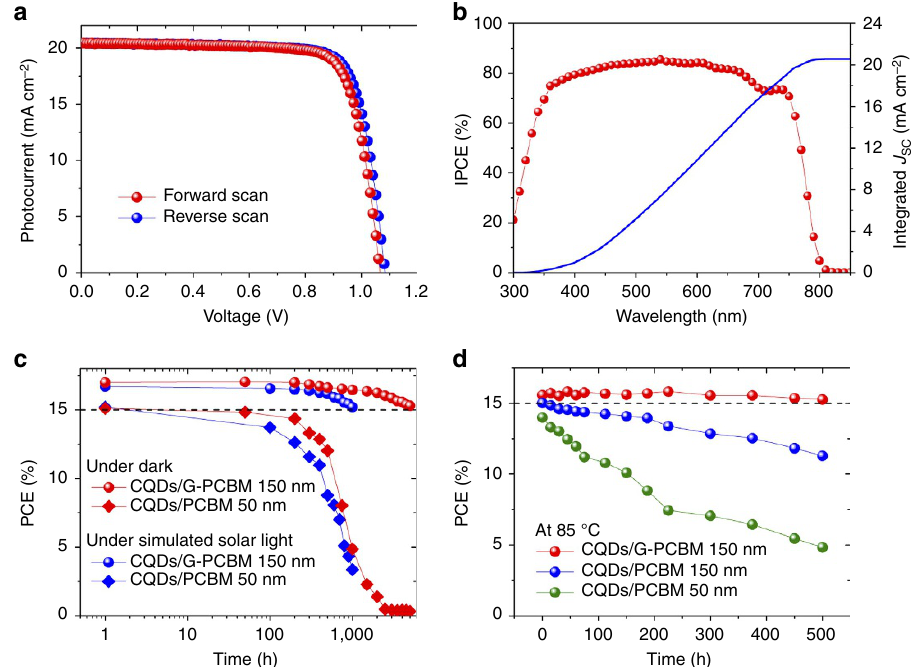
Figure 3 | Performance of PSCs. ( a ) The photocurrent current–voltage characteristics of one device with the structure of NiMgLiO/Perovskite/N-doped graphene fullerene derivative phenyl-C61-butyric acid methyl ester (G-PCBM) (150nm)/CQDs (10nm)/Ag, measured under simulated solar light (AM 1.5G, 100mWcm (cid:2) 2 ). ( b ) Its IPCE spectrum. ( c ) The stability of sealed devices under dark and under air AM 1.5G simulated solar light. ( d ) The stability of sealed cells in thermal ageing test at 85 (cid:2) C in an atmosphere with relative humidity of about 50%.